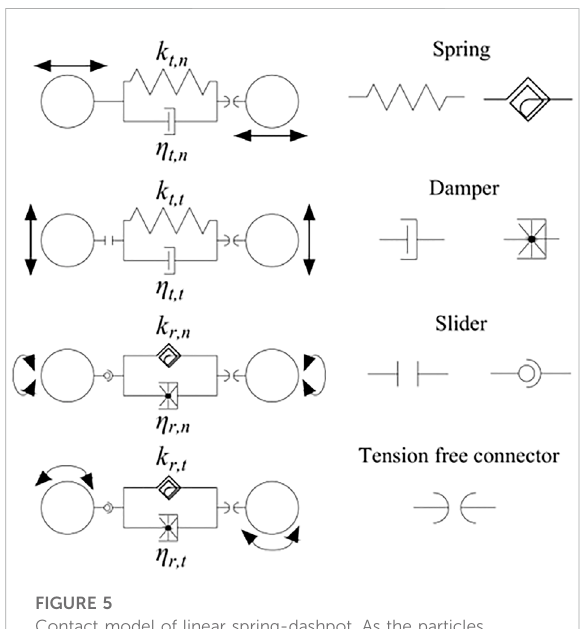
FIGURE 5 Contact model of linear spring-dashpot. As the particles interact,theresultingcontactnormalforce F n